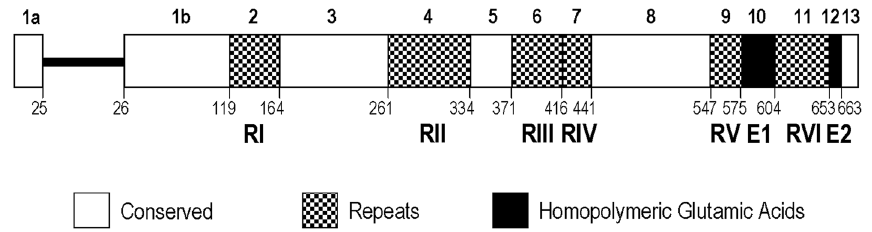
Figure 1. Schematic representation of PfGARP . Exons are shown as boxes and an intron as a dense line. Boxes are numbered above the scheme. Exons are characterized by conserved, repeats and homolymeric glutamic acids regions. Amino acid position at the end of each block/domain is indicated beneath the scheme. The nucleotide positions for boxes Ia, Ib and II to XIII are 1–75, 290–571, 572–706, 707–997, 998–1215, 1216–1327,